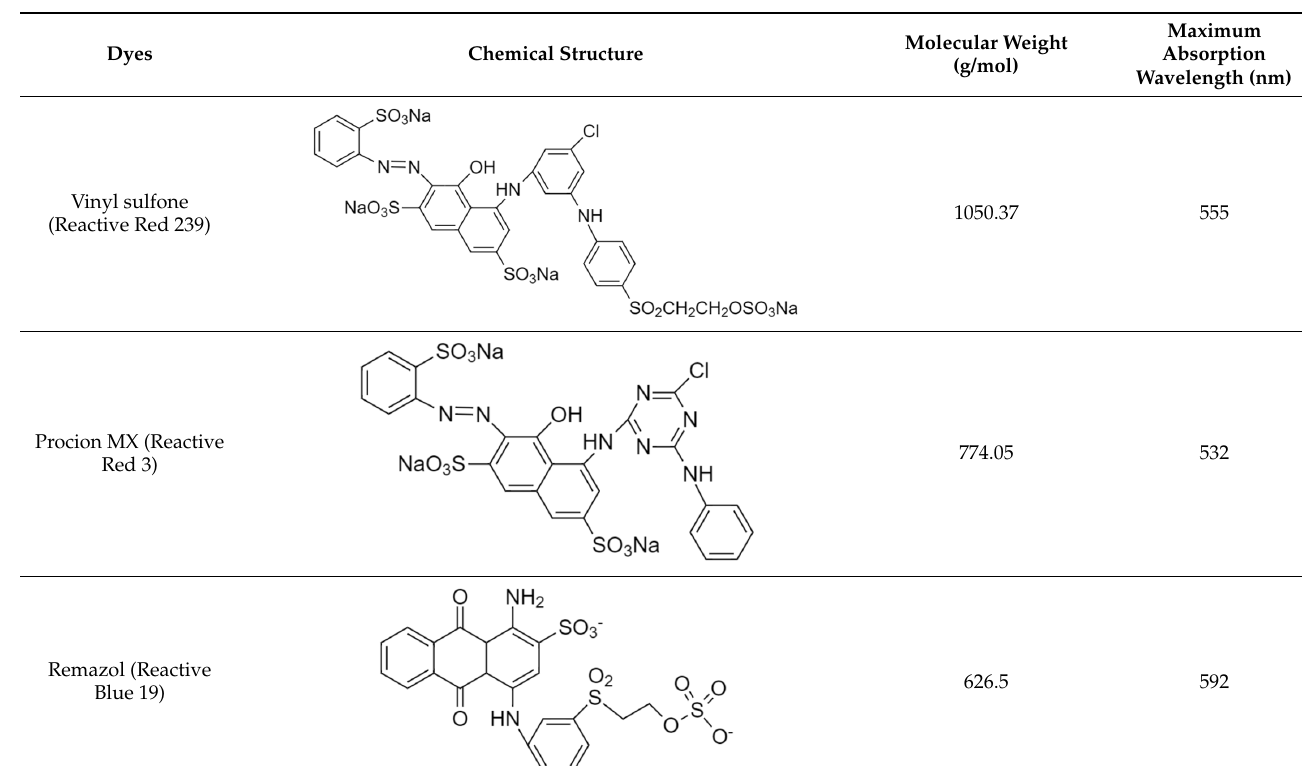
Table 2. Structure of several reactive dyes [14].